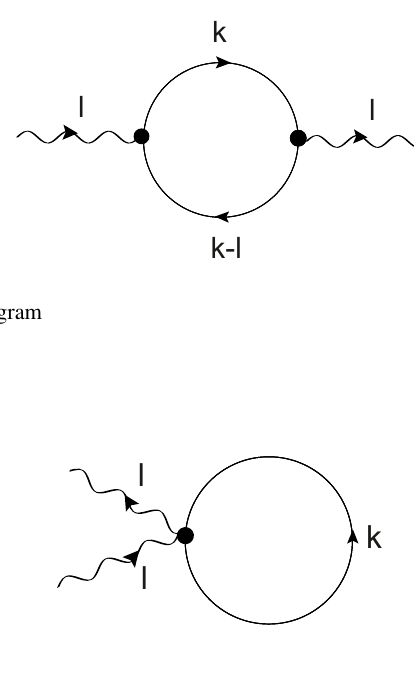
Figure 2. Tadpole Feynman diagram: they arise in the OSEFT to give account of photon-particle / antiparticle interactions mediated by an o ff -shell antiparticle /